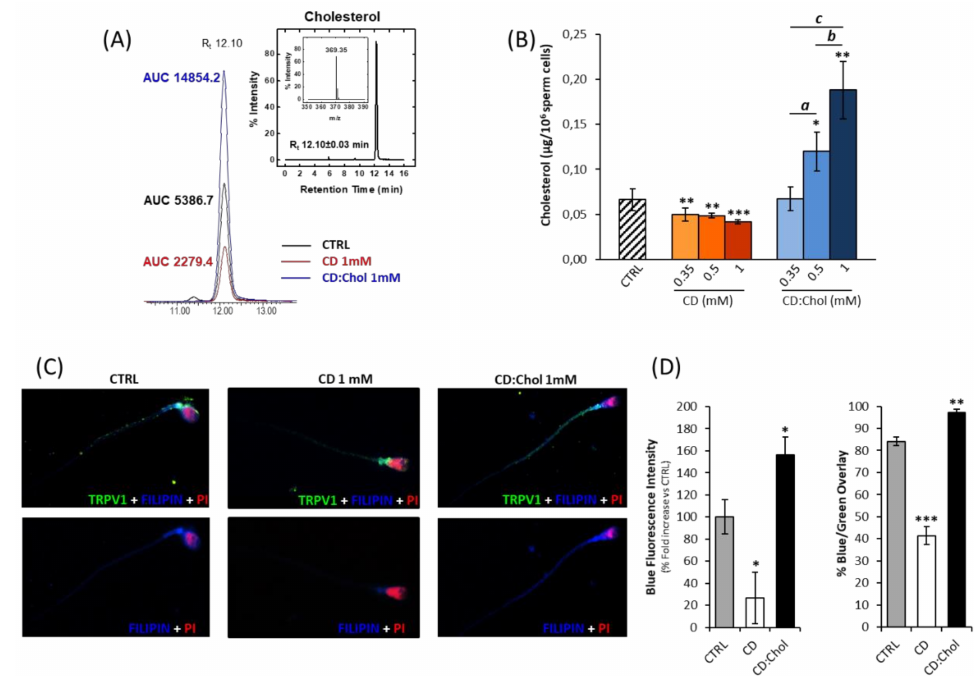
Figure 1. Experimental modification of the membrane cholesterol content with cyclodextrin ap- proach. ( A ) Representative images of ultrahigh performance liquid chromatography-mass spec- trometry (UPLC-MS) analysis of cholesterol (Chol) content in naïve sperm cells (CTRL), in sperm cells incubated with 2-hydroxypropyl-ß-cyclodextrin (CD) or with the complex between CD and Chol (CD:Chol), both at the concentration of 1 mM. The chromatographic peaks are flanked by the respective values of area under the curve. The inset shows a representative chromatogram of Chol standard and the corresponding high-resolution MS spectrum with a monoisotopic mass value of 369.35 atomic mass units (a.m.u). ( B ) UPLC-MS quantification of Chol in sperm cells incubated with CD or CD:Chol, at concentrations ranging from 0 (CTRL) to 1 mM. Data are expressed as µ g of Chol per 10 6 sperm cells. Significance: * = p < 0.05, ** = p < 0.01, *** = p < 0.001 vs. CTRL; a = p < 0.05, b = p < 0.01 and c = p < 0.001 between the indicated conditions. ( C ). Immunofluorescence staining of TRPV1 (green) and cholesterol, detected by Filipin II (blue), in naïve sperm cells (CTRL) and cells treated with 1 mM CD or 1 mM CD:Chol. Cell nuclei were counterstained with propidium iodide (PI, red). The upper panels show the merging of the three colors’ channels, whilst in the lower panel the green channel was omitted for clarity. In ( D ) the image analysis is reported. The left plot shows the blue fluorescence staining intensity, reported as %-fold increase compared to CTRL; the right plot shows the percentage of overlay between the green (TRPV1) and the blue channels (Chol). Significance: * = p < 0.05, ** = p < 0.01, *** = p < 0.001 vs.